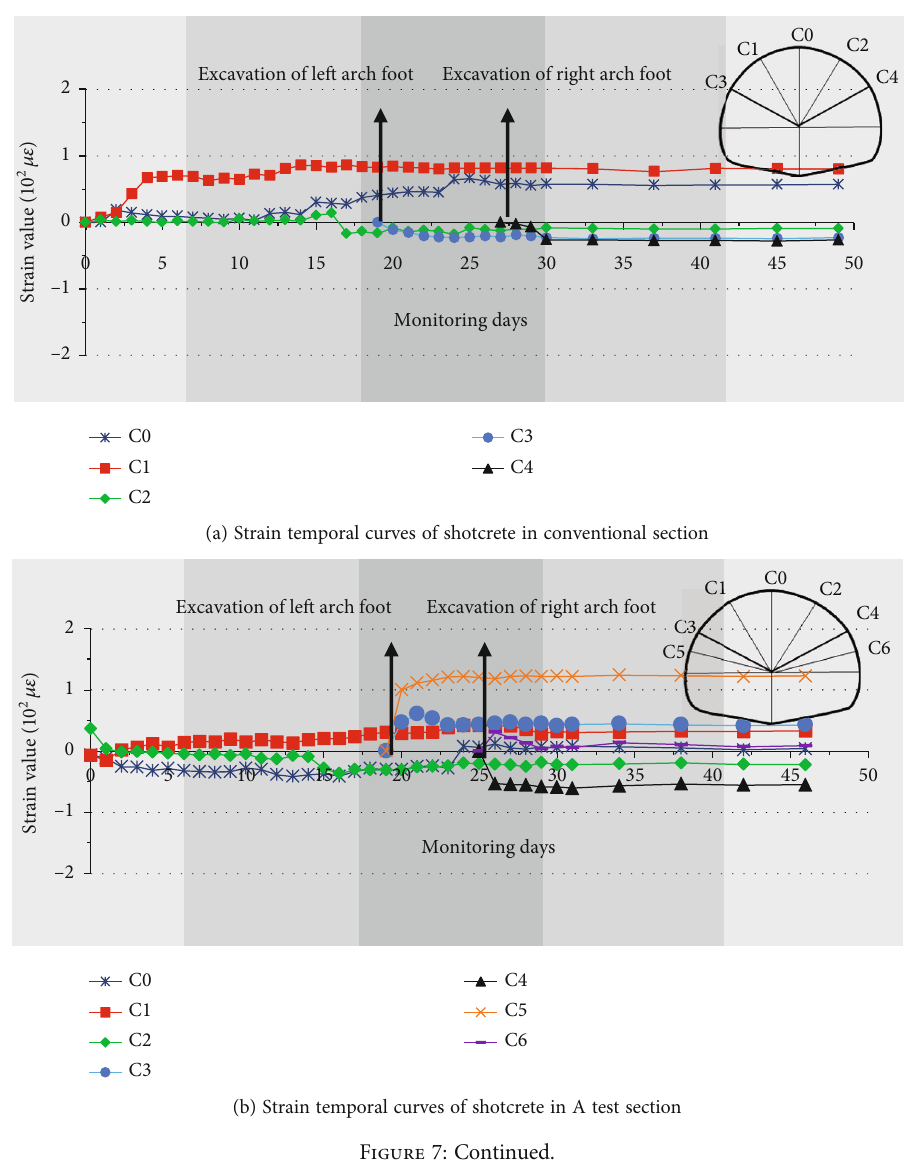
(b) Strain temporal curves of shotcrete in A test section Figure 7: